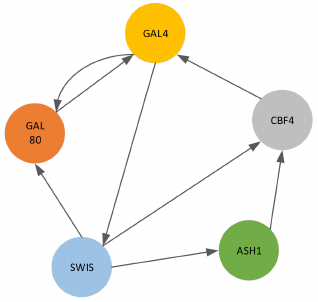
Figure 4. The network structure of Saccharomyces